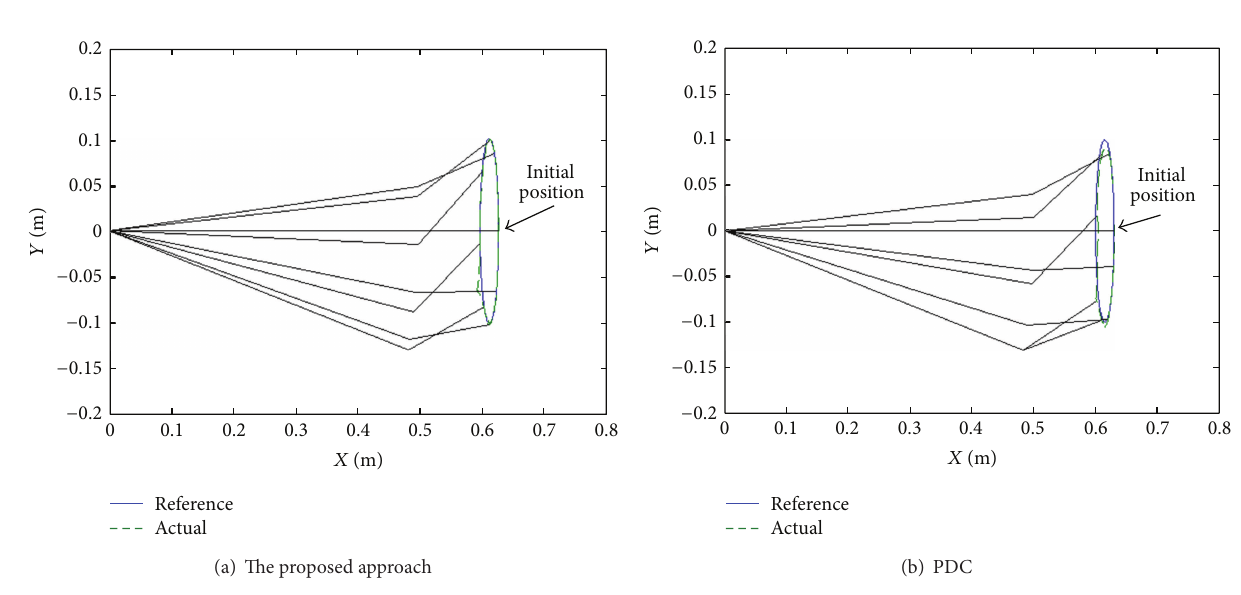
Figure 8: Elliptic response of the proposed approach and